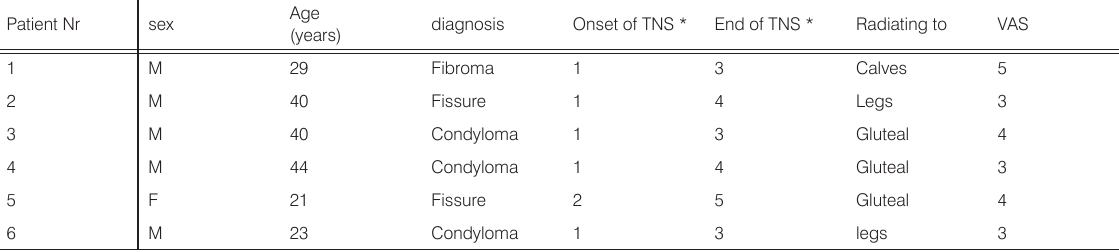
Table 5. Details of patients suffering from transient neurologic symptoms